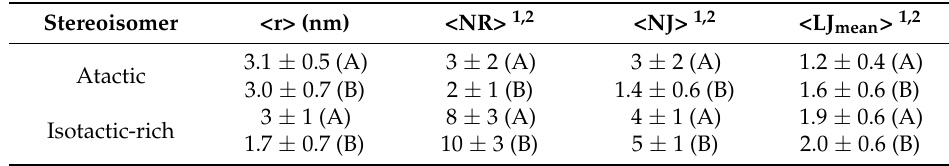
Table 1. End-to-end distance of chains and features of the interchain junctions at 283 K. Stereoisomer